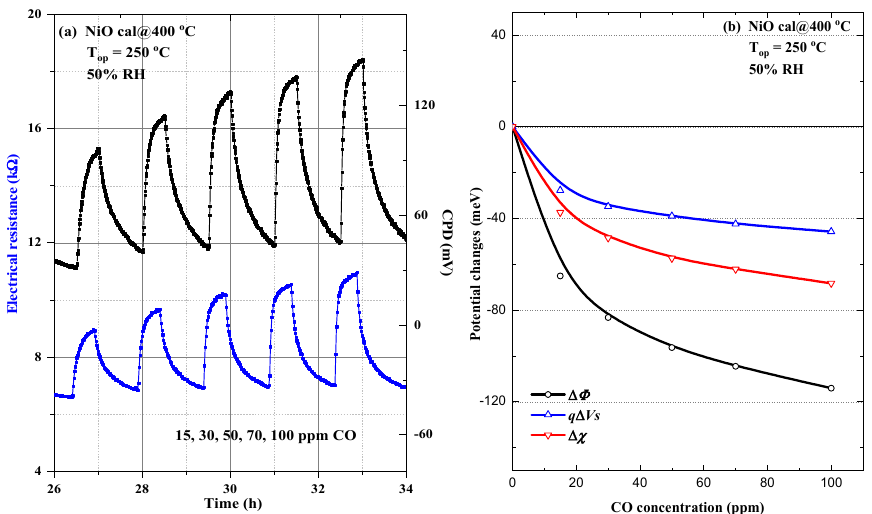
Figure 7. Electrical resistance and CPD changes with respect to the CO concentration ( a ); potential changes under CO exposure for NiO calcined at 400 °C ( b ).